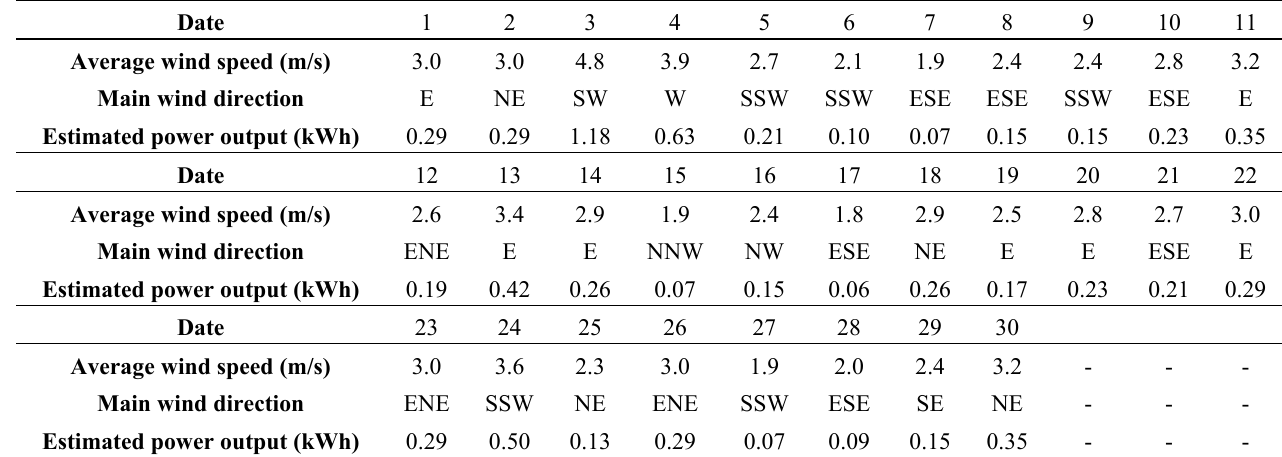
Table A9. Estimated power output per day in